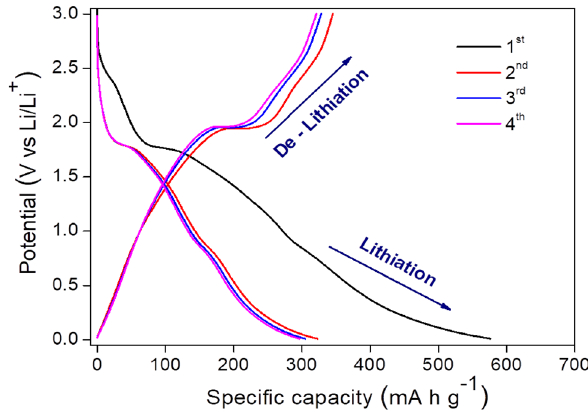
Fig. 8 Galvanostatic charge–discharge profile of B-TiO